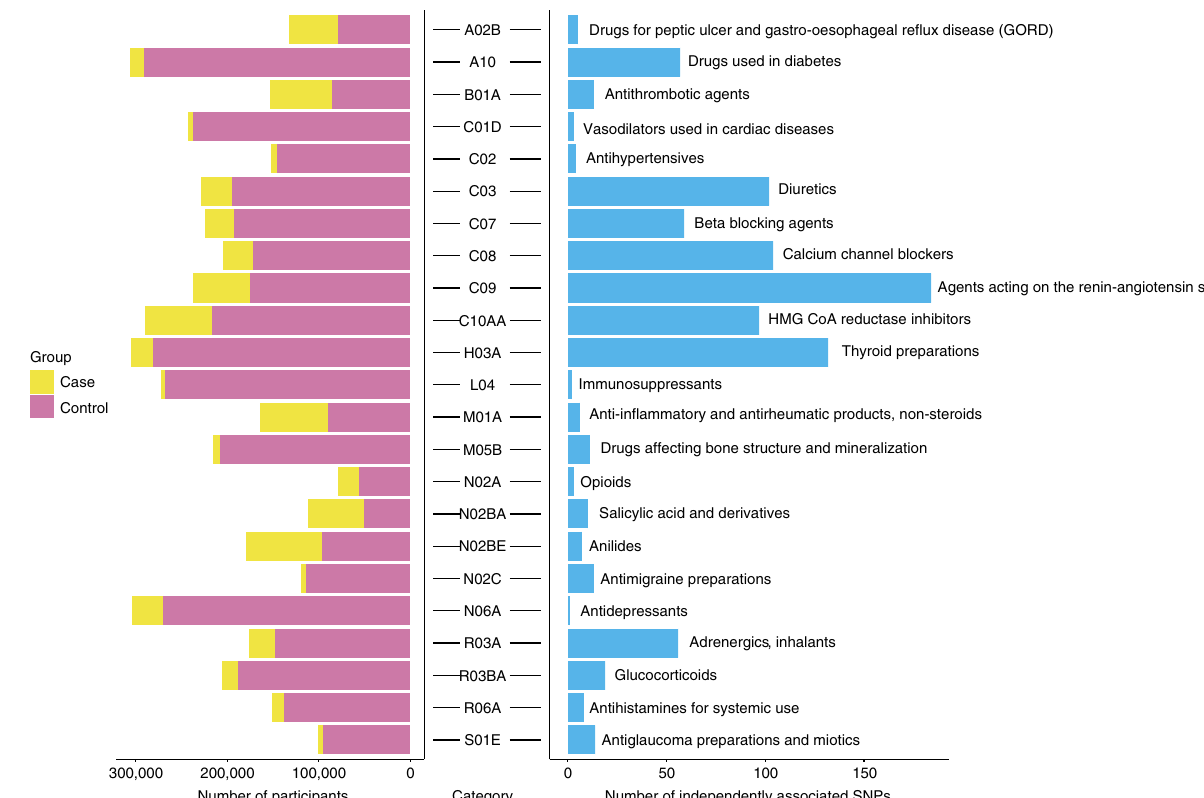
Fig. 2 Summary of UKB medication-taking GWAS analyses. For each category, the number of cases and controls is shown on the left and the number of independently-associated SNPs on the right. Text on the right gives the meaning of each medication-taking ATC coded